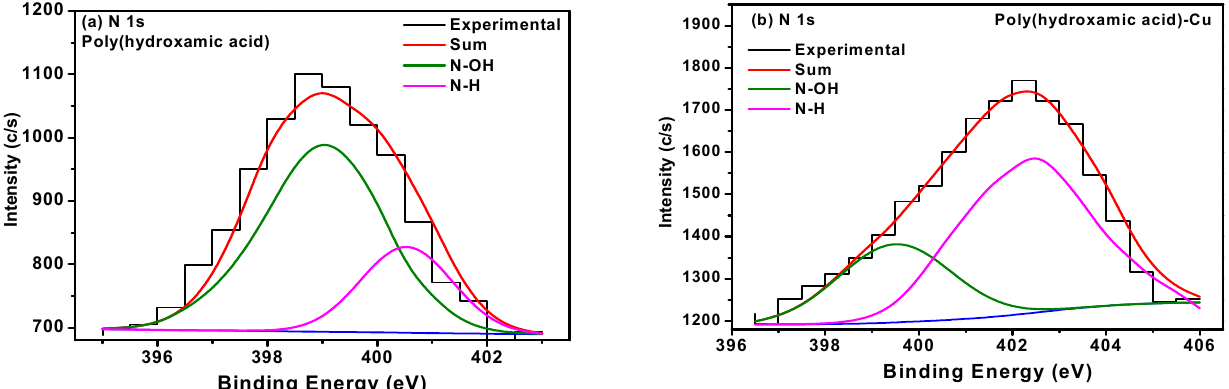
Figure 7. N1s core-level XPS spectra of ( a ) poly(hydroxamic acid) ligand and ( b ) poly(hydroxamic acid)-Cu(II) complex.